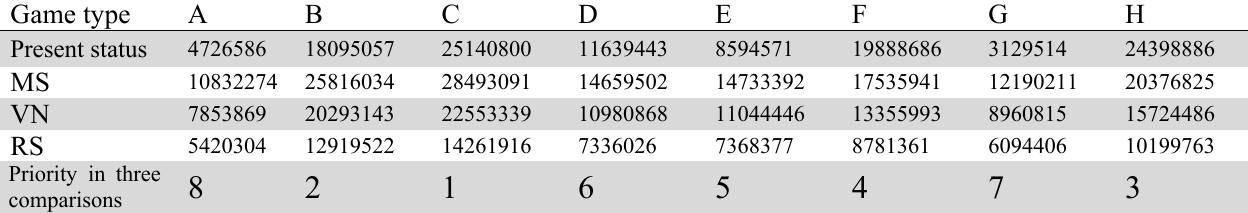
Prioritization of manufacturers based on manufacture profit